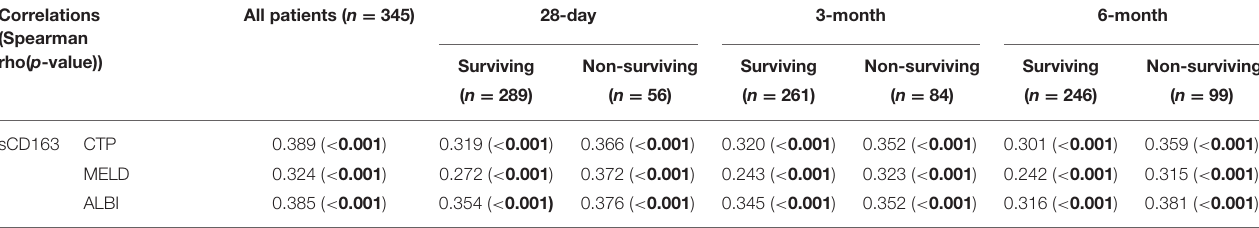
TABLE 3 | Correlations between sCD163 and scores for liver disease severity (CTP, MELD and ALBI scores). Correlations